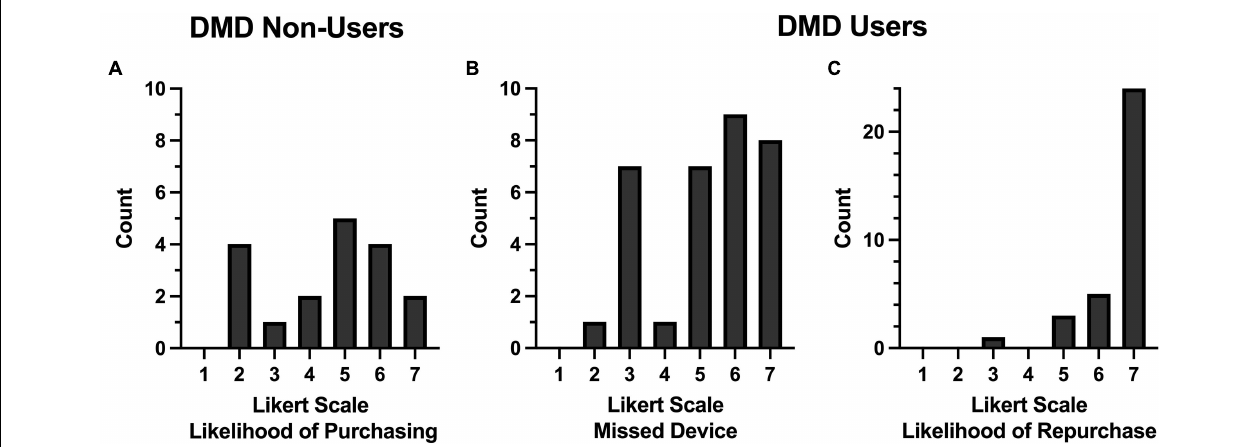
FIGURE 2 | Histograms of the number of participants who provided a particular response on a seven-item Likert scale to follow-up questions. Note the different y -axis scale used in C. (A) DMD non-users indicated on a scale of 1 (very unlikely) to 7 (likely) how likely they would be to purchase a DMD. (B) DMD users indicated how much they missed their DMD when asked to play without it on a scale of 1 (did not miss at all) to 7 (miss it very much). (C) DMD users indicated on a scale of 1 (very unlikely) to 7 (very likely) how likely they would purchase another